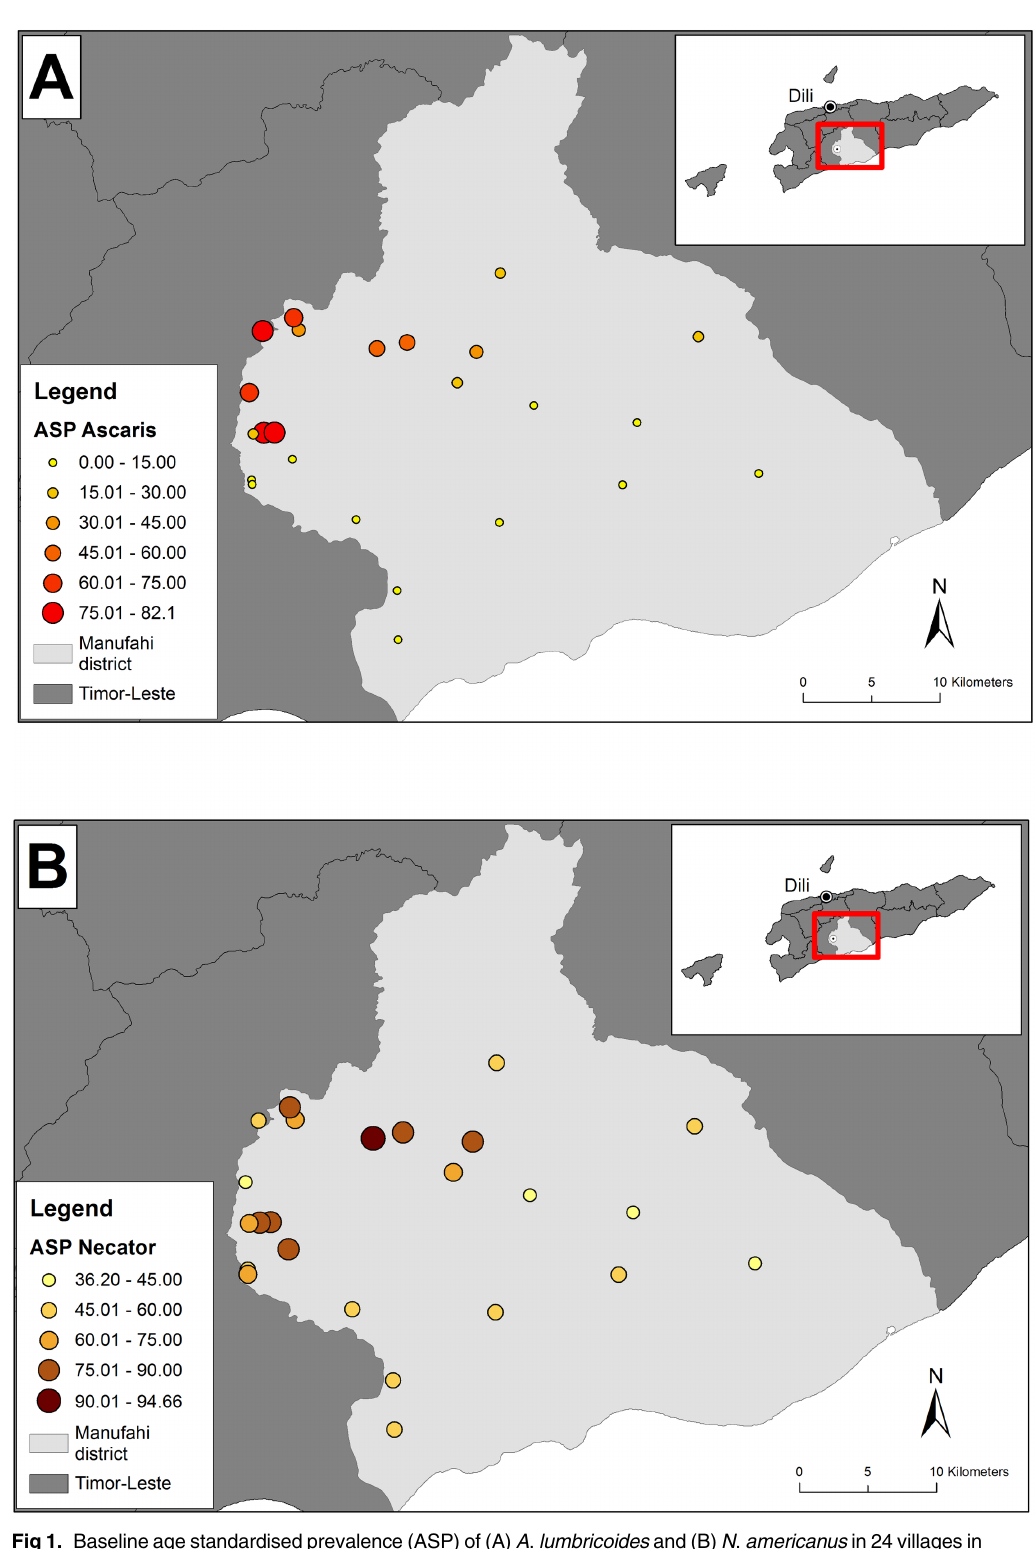
PLOS NeglectedTropical Diseases | https://doi.org/10.1371/journal.pntd.0005565 May 10,